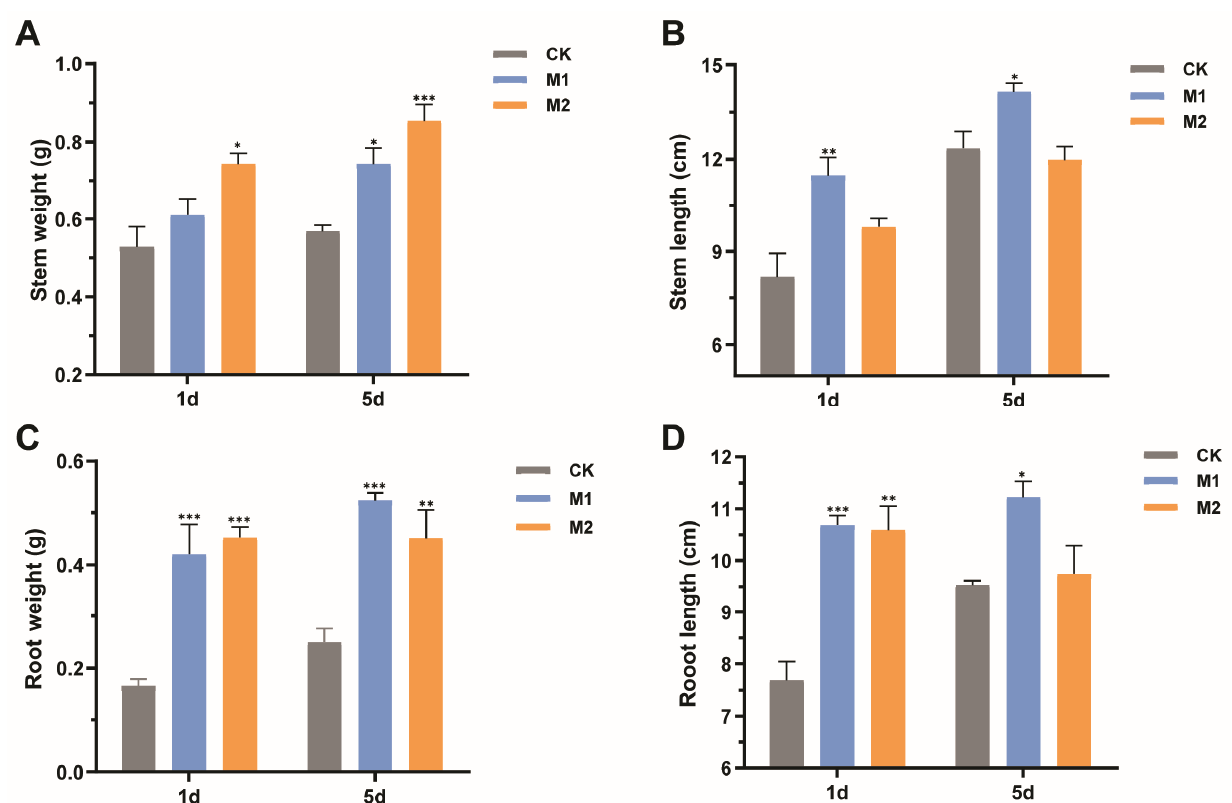
Figure 6. Effects of two types of mixed fungal suspensions on mulberry growth recovering eight weeks after suffering from drought stress. ( A ) Stem fresh weight. ( B ) Stem length. ( C ) Root fresh weight. ( D ) Root length. M1 represented mulberry seedlings treated with mixed fungi suspensions consisting of Talaromyces sp. GS1 and Pseudeurotium sp. GRs12 at the initial concentration, and Penicillium sp. GR19 and Trichoderma sp. GR21 at the 10-fold diluted suspensions. M2 represented mulberry seedlings treated with mixed fungi at the 100-fold dilution suspensions. CK represented mulberry seedlings treated with water. Data represent mean ± standard deviation ( n = 4). Statistically significant differences between fungi-treated and control mulberry seedlings suffering 1 day and 5 days of drought stress were, respectively, analyzed using Dunnett’s one-way analysis of variance. *** p < 0.001, ** p < 0.01, * p <